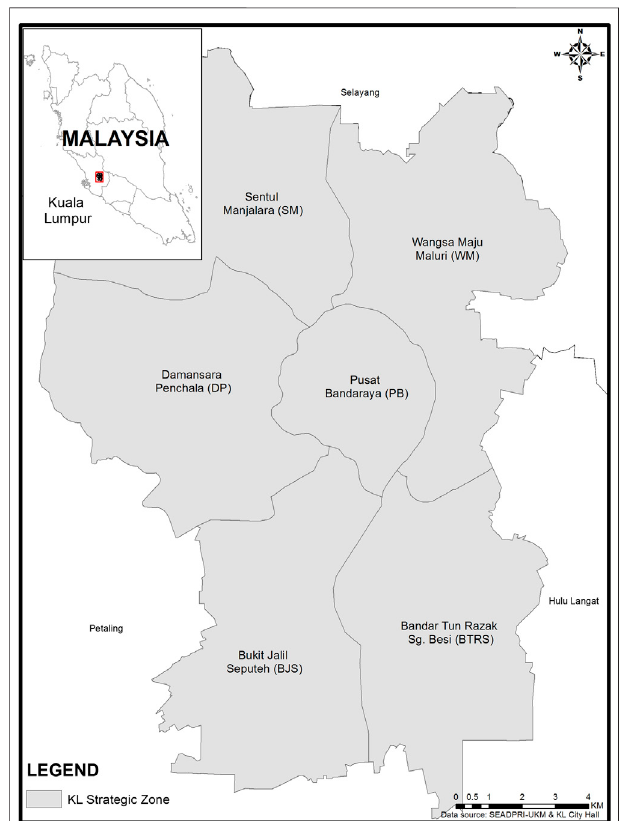
FIGURE 1 | Kuala Lumpur is located within the State of Selangor in Peninsular Malaysia and comprises several strategic